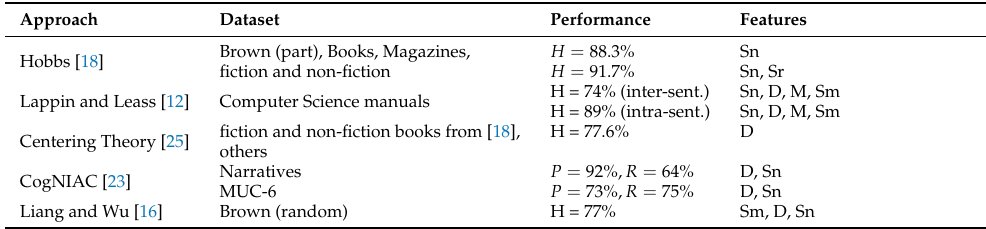
Table 1. Anaphora Resolution algorithms performance as reported in